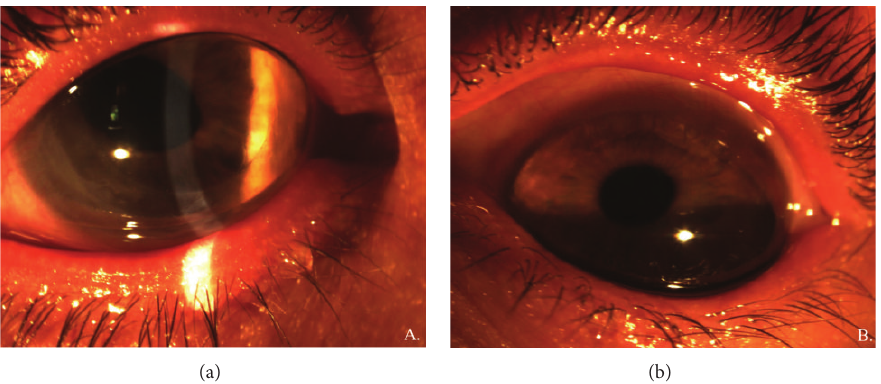
Figure 1: External photographs of the right (a) and left (b) eyes eight months after DSEK. (a) A 9mm in diameter clear graft is evident. The graft appears small in an eye with a 15mm cornea in diameter. (b) Diffuse ecstatic cornea is seen. The patient with keratoglobus is looking down slightly to show extreme corneal protuberance.